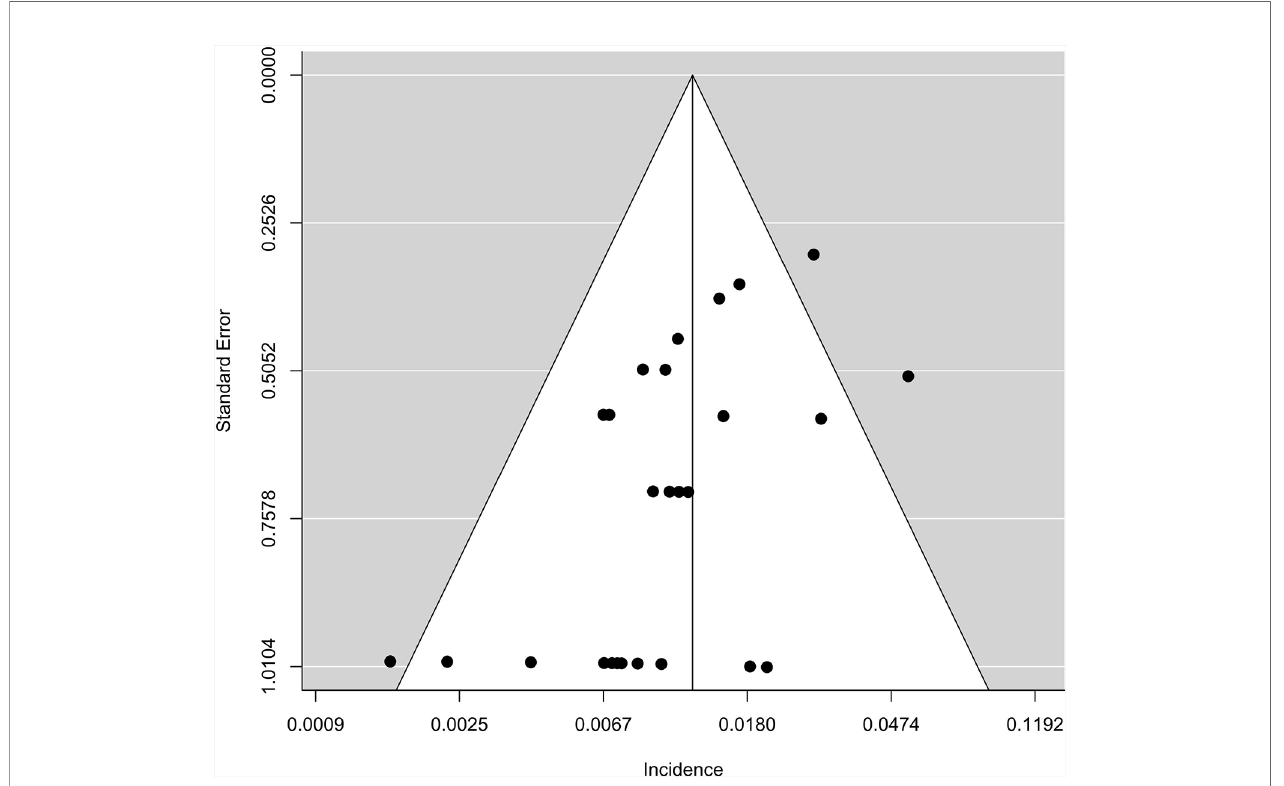
FIGURE 4 | The funnel plot of publication bias in the